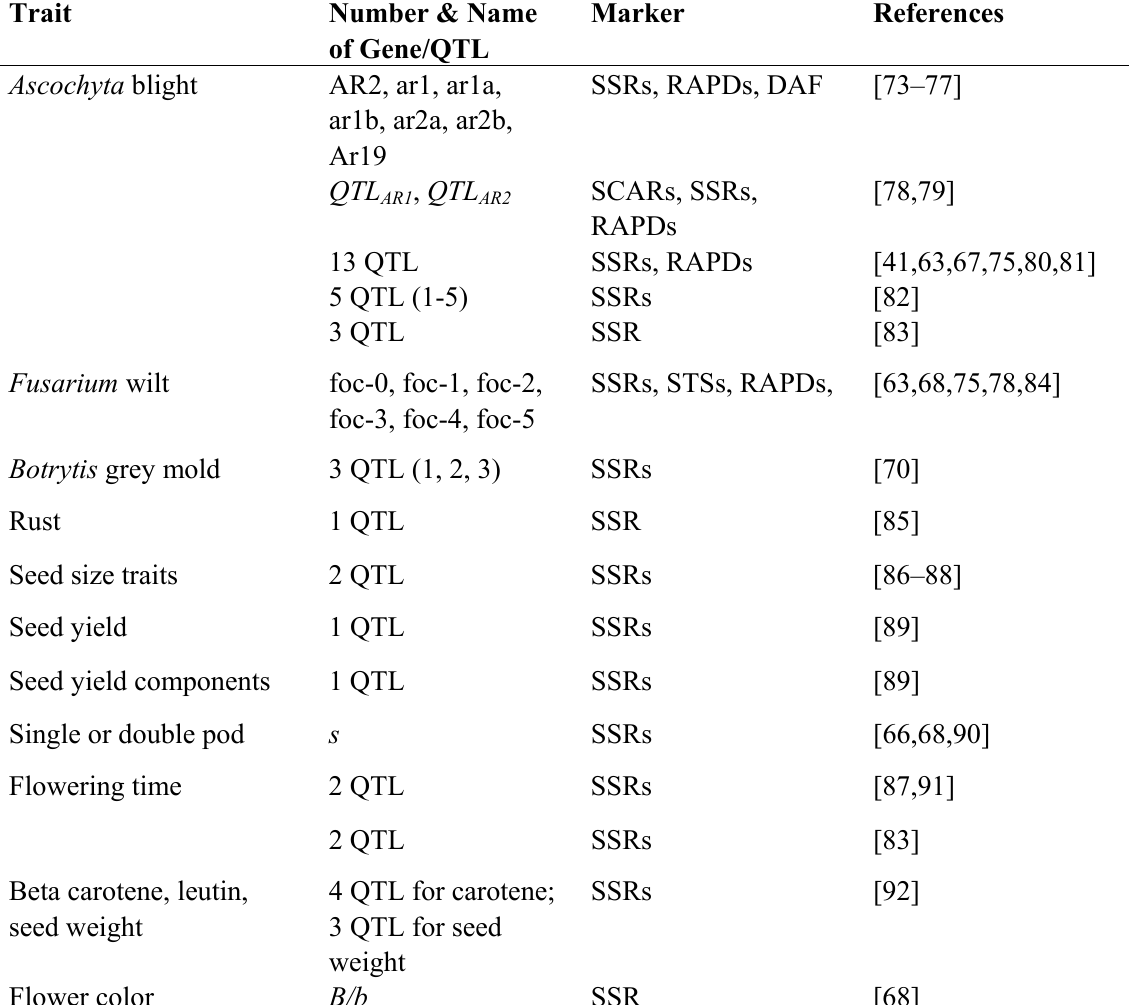
Table 2. List of some QTLs/genes identified for different traits in